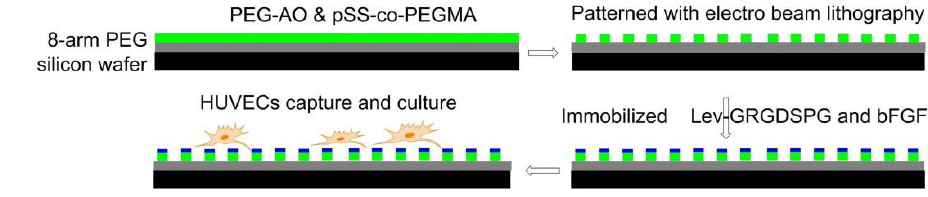
Figure 10. Electron beam lithography. Before immobilizing Lev-GRGDSPG and bFGF on the surface, pSS-co-PEGMA and PEG-AO were coated and cross-linked on passivated silicon wafers. Then HUVEC cells were cultured on the surface.